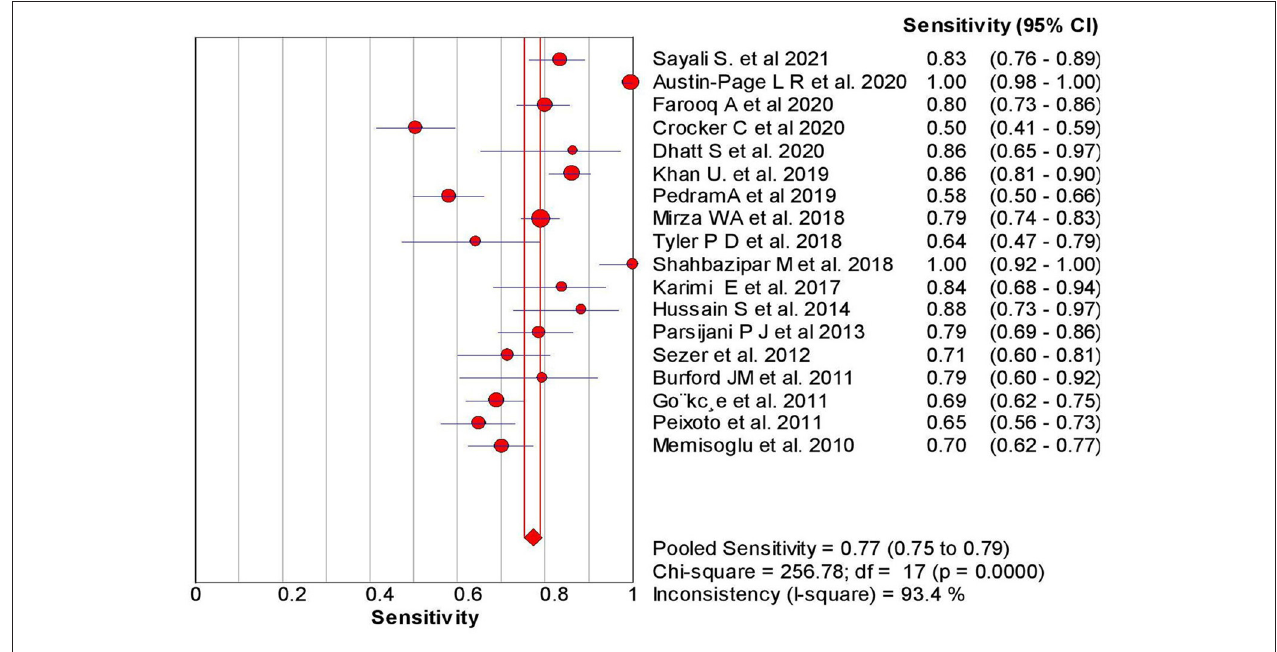
FIGURE 2 | Sensitivity of ultrasound in acute appendicitis cases.